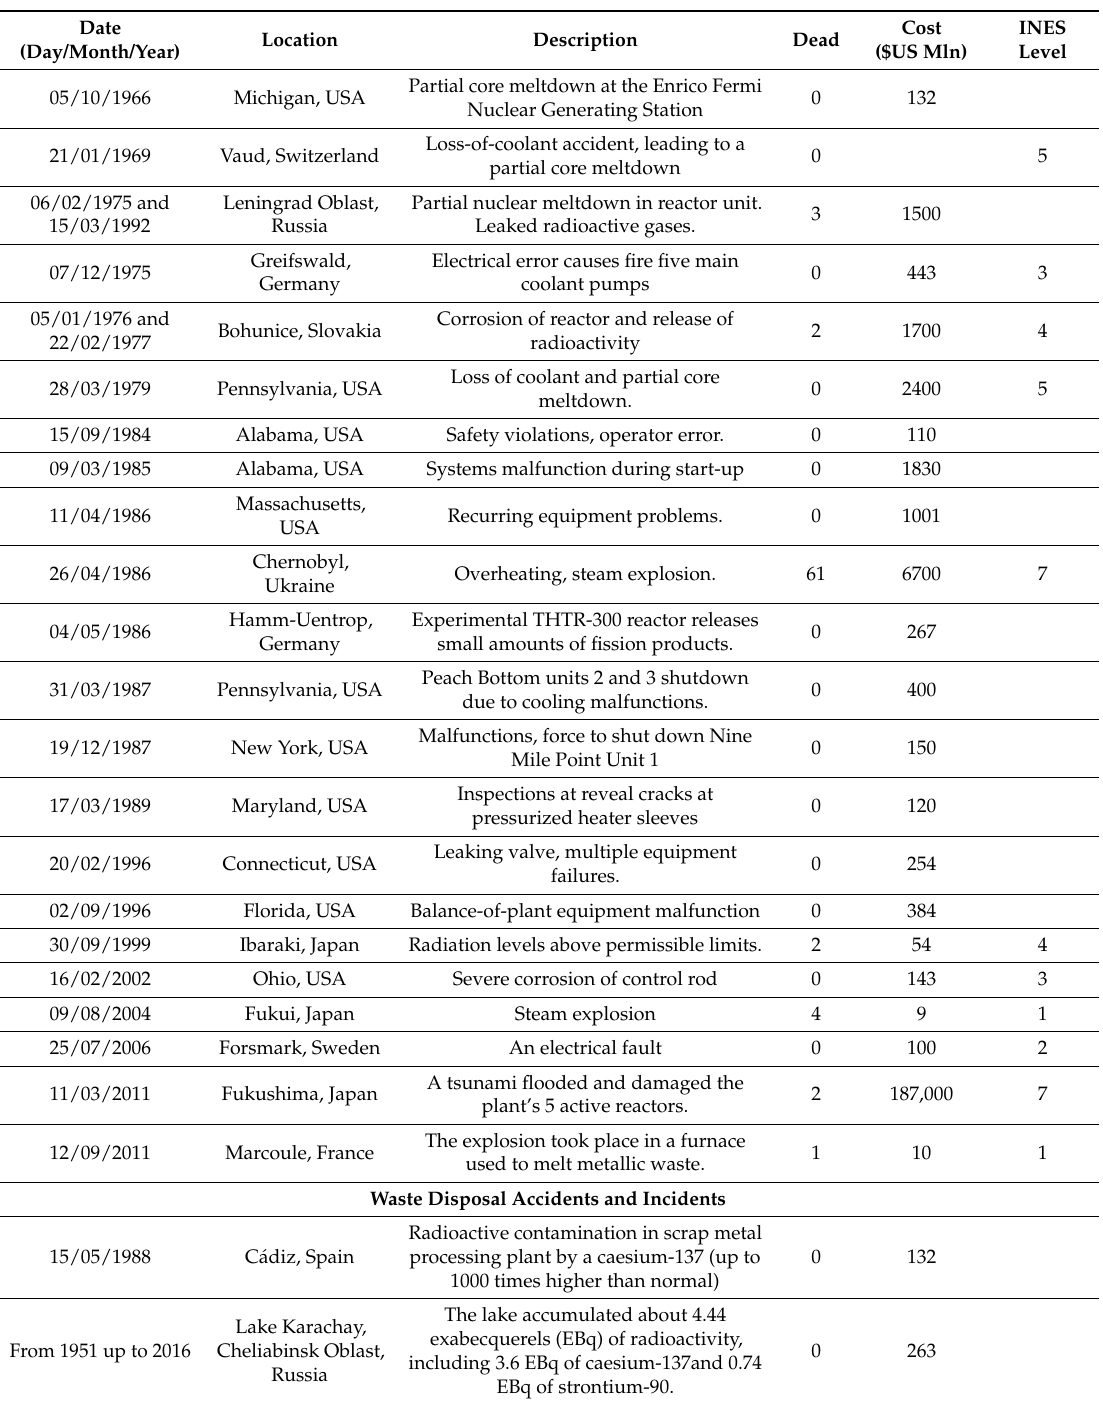
Table 3. Main Nuclear power plant and radioactive waste disposal accidents and incidents (with multiple fatalities and/or more than US$10 million in damage, 1965–2011)